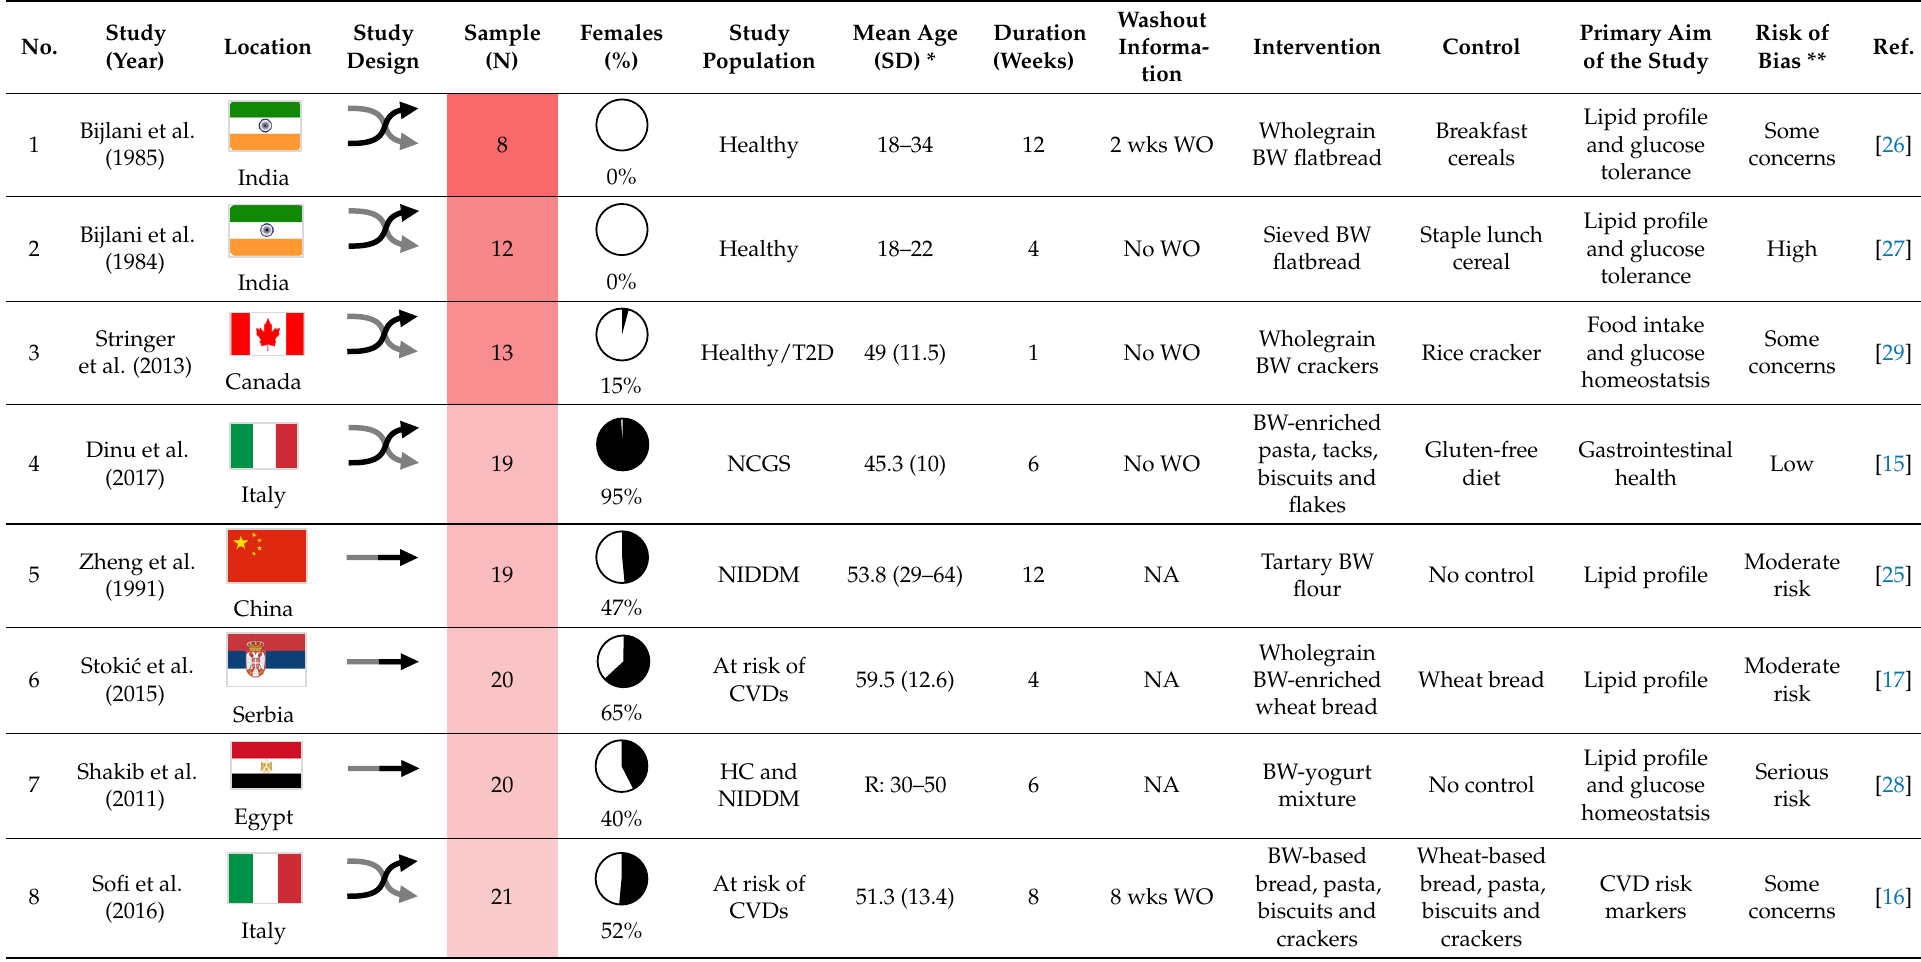
Table 2. Characteristics of studies included in systematic review.